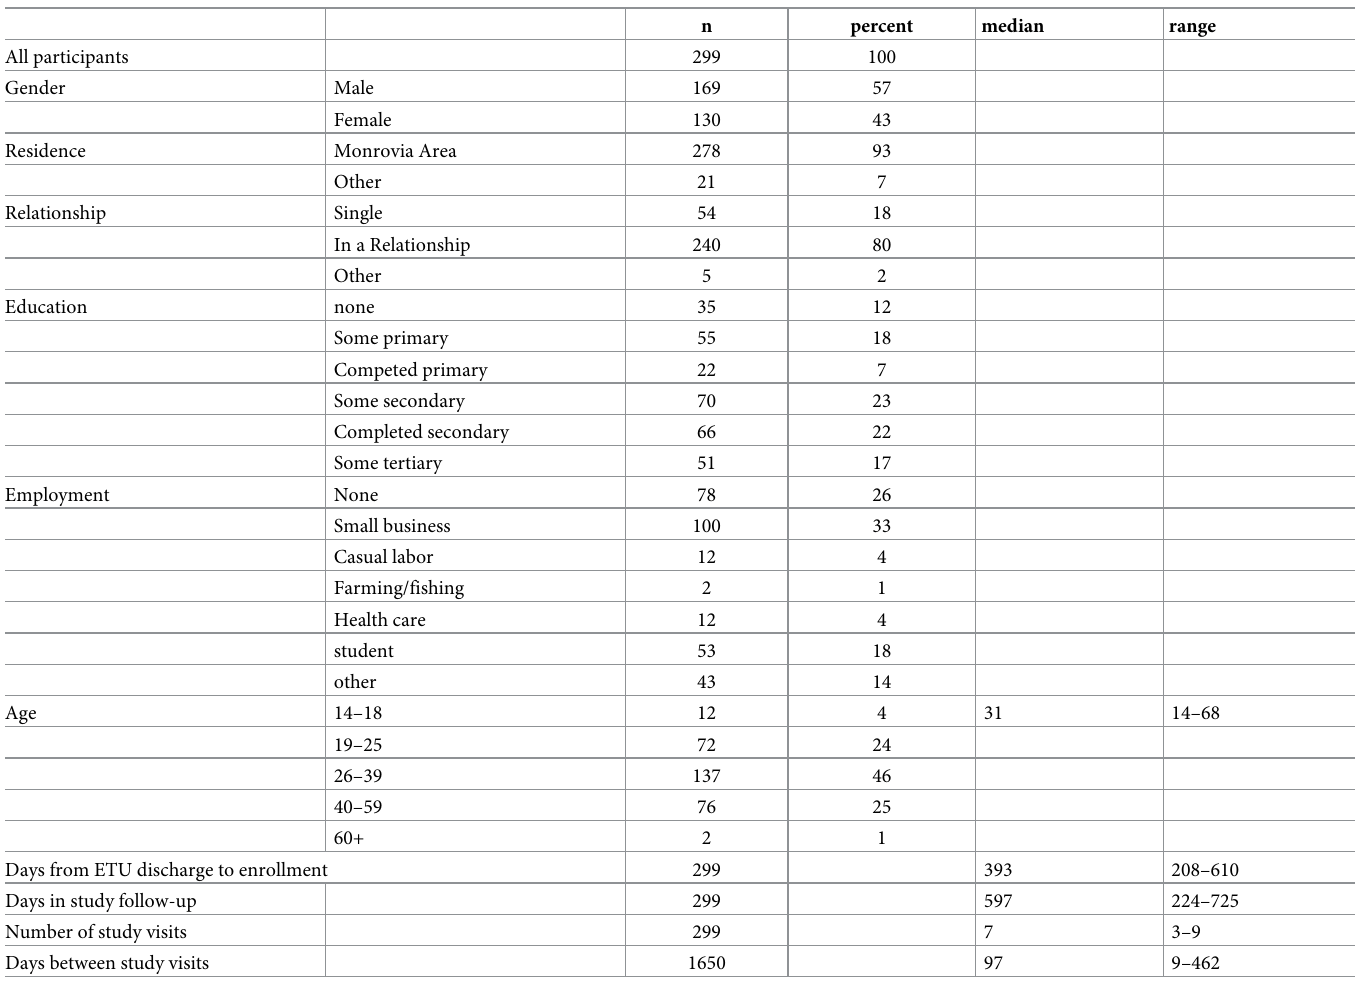
Table 2. Characteristics of study